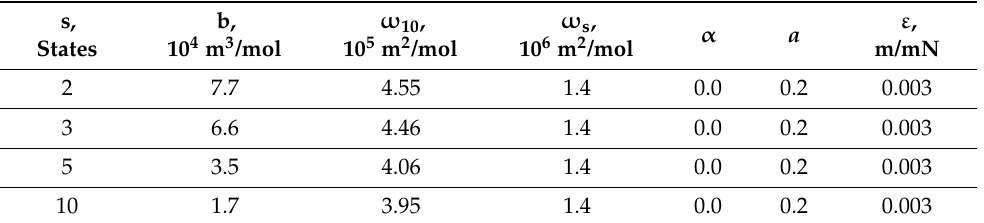
Table 2. Parameters of the isotherms of C 14 EO 8 solutions assuming 2, 3, 5, and 10 states of the multistate adsorption Model